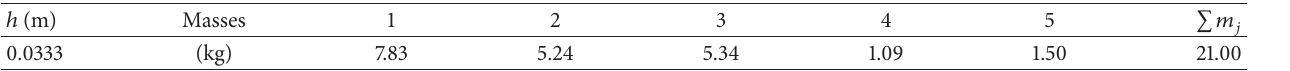
Table 12: Optimal design variables results (Case2B).